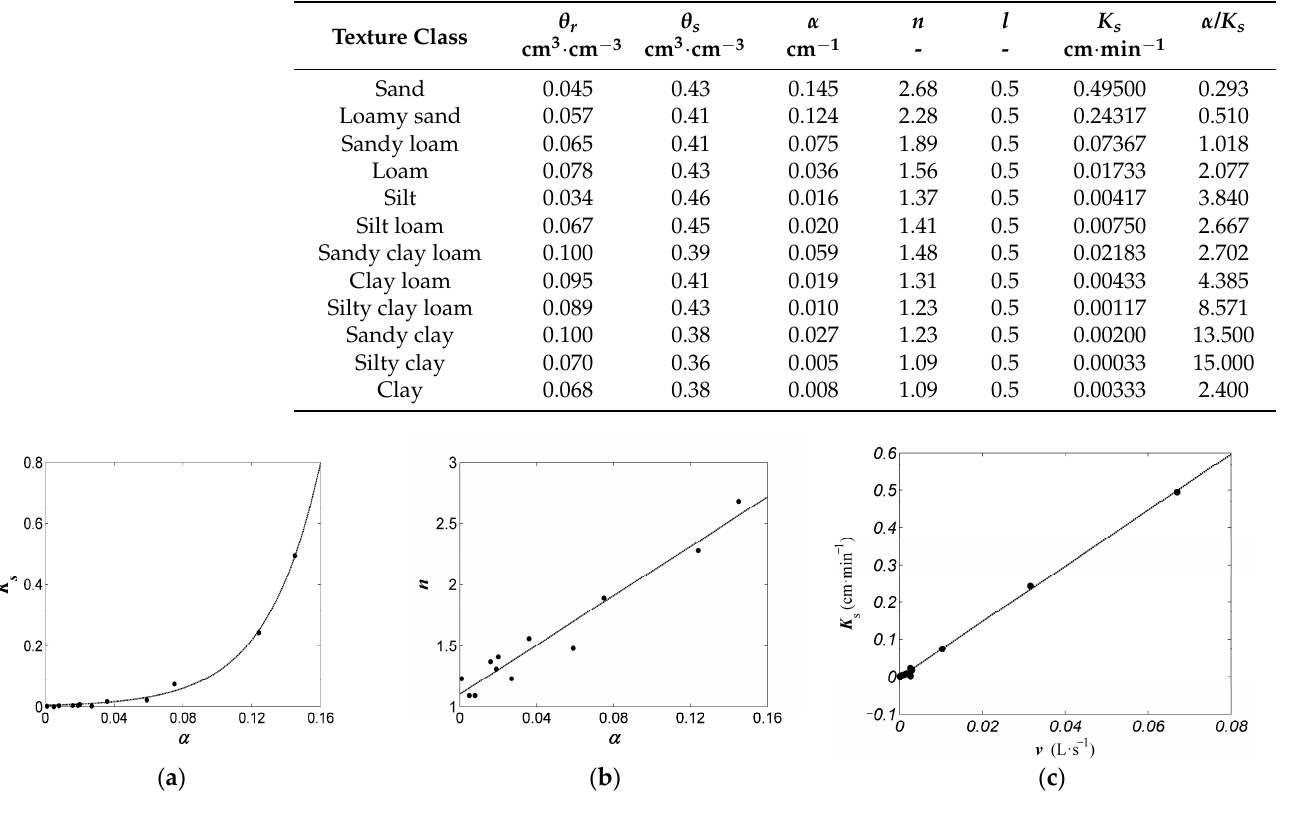
Table 1. Soil hydraulic parameters for the van Genuchten–Mualem model (RETC).